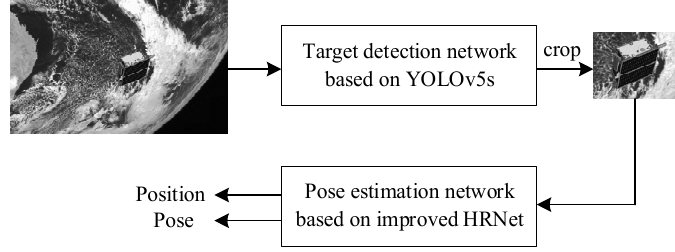
Figure 1. Retinaface face prediction network frame diagram.